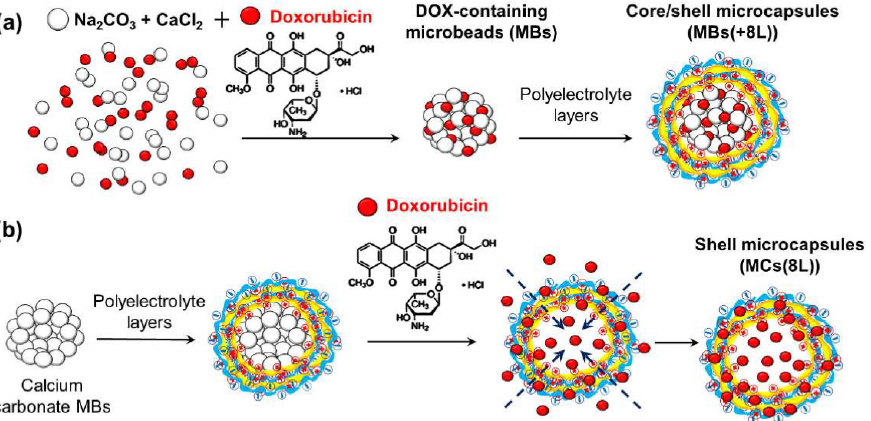
Figure 12. Sketch of the fabrication for LbL of different types of capsules for theranosis purposes. ( a ) Co-precipitation method. ( b ) Direct drug adsorption. MB: Microbeads, MC: Microcapsules. Reprinted from Kalinechenko et al. [36], with permission under Open access CC BY 4.0 license, https://creativecommons.org/licenses/by/4.0/ (accessed 20 January 2022).